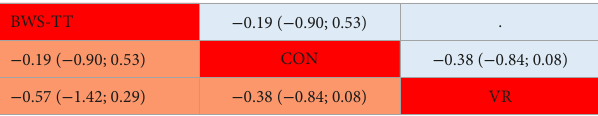
Blue means relative degree of direct comparison between gait training. Light red means relative degree of combined comparison between gait training. Deep red means gait training. BWS-TT, body-weight-supported treadmill training; VR, virtual reality gait training; CON, control